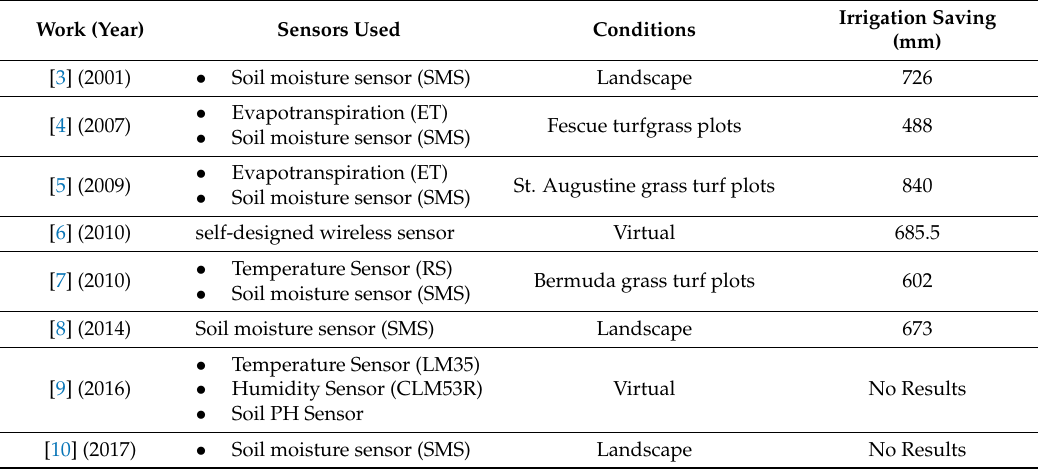
Table 2. Comparison of the efficiency of various irrigation